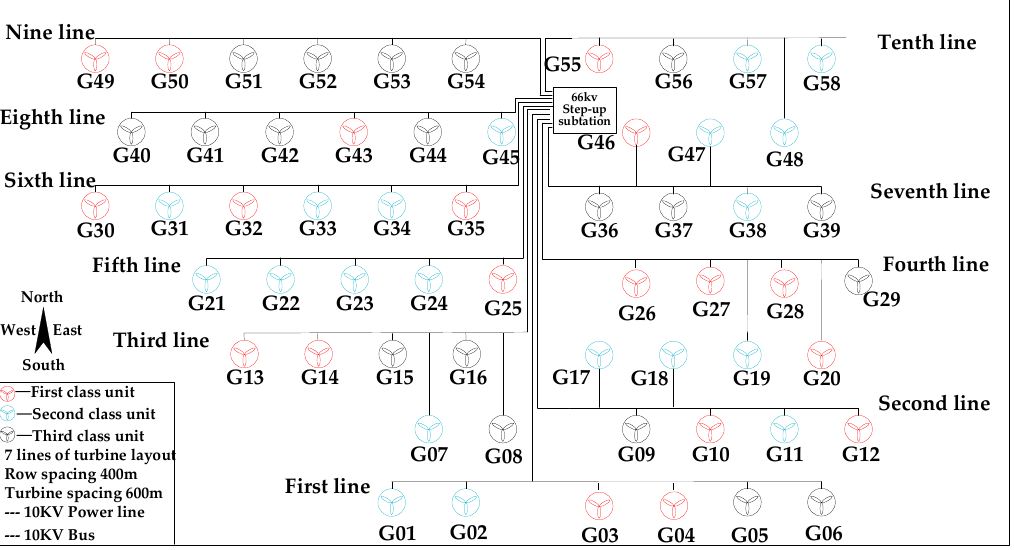
Figure 10. Turbine layout.